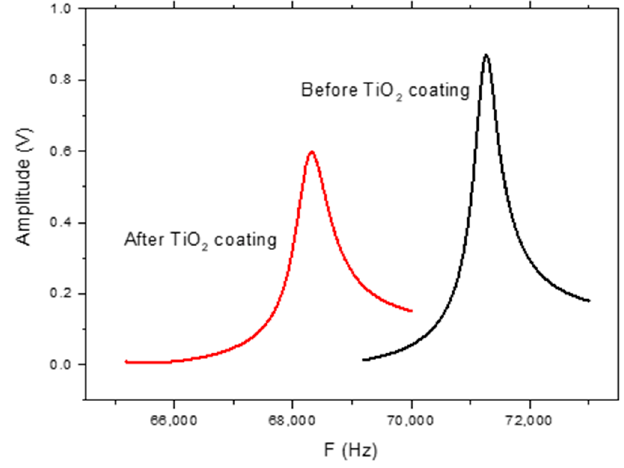
Figure 10. Frequency spectrum of MES-4, before and after TiO 2 -NTs coating at a 400 A / m magnetic field.